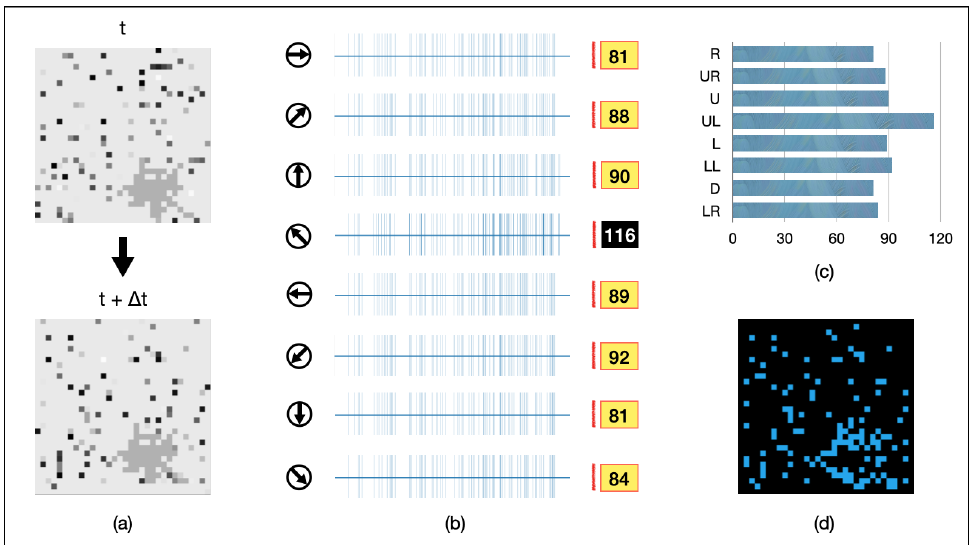
Figure 12. An AVS motion direction detection instance in dynamic background noise: ( a ) two successive frames of an upper leftward motion of an 64-pixel object; ( b ) activation map of the eight LMDNs during scan; ( c ) LMDNs activations are counted by a bar chart; ( d ) activated pixels by all the LMDNs during detection process are marked by